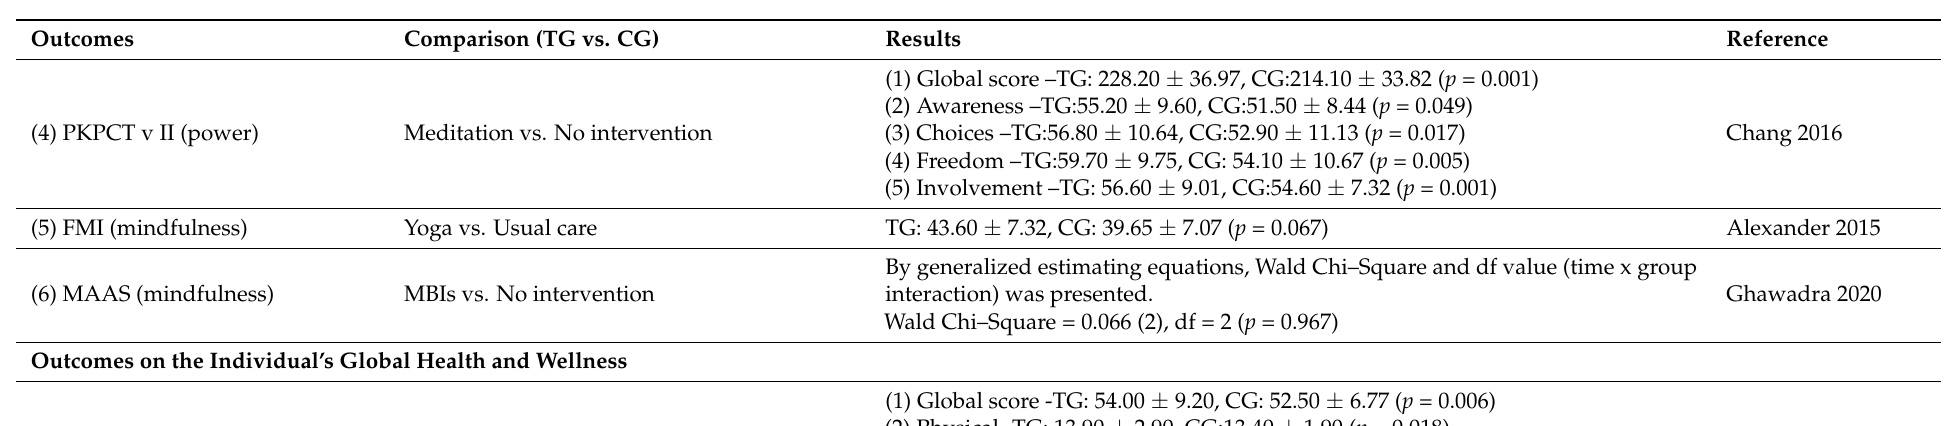
interaction) was presented.